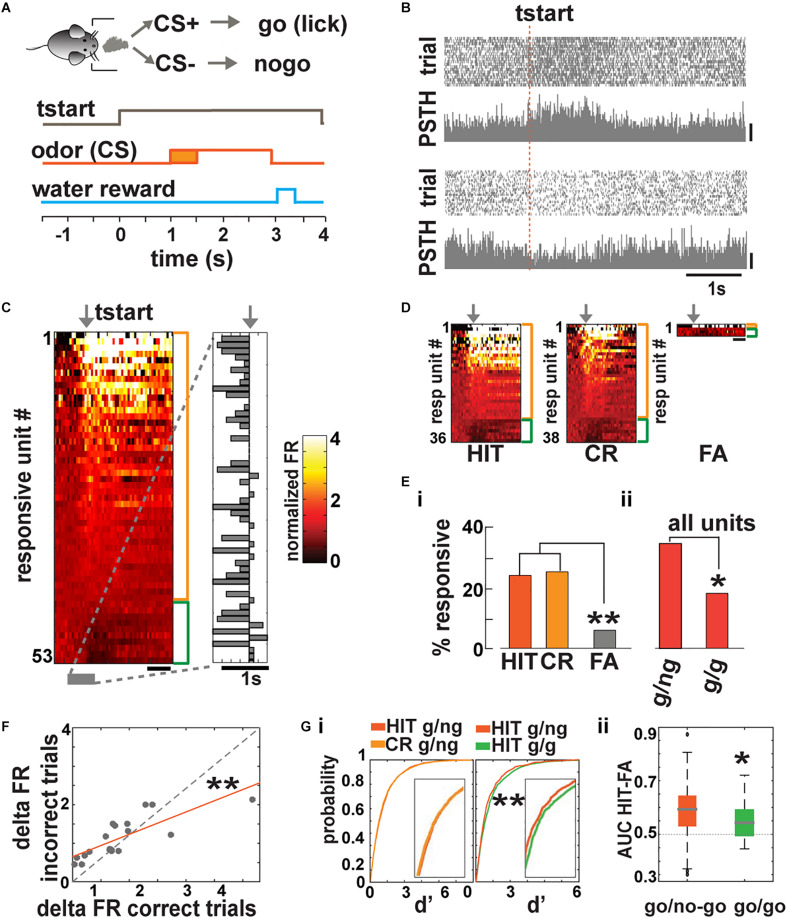
Basal forebrain (BF) neuronal activity is recruited during trial initiation in a go/no–go task. (A) The odor is delivered 1.5 ± 0.5 s after the mouse starts the trial. In response to CS+, the animal must lick at least once in four 0.5-s segments to receive a water reward. (B) Spike scatterplot for two BF single units in the go/no–go task for a mouse performing >80% correct responses. FR increased for one unit (top; scale bar, 50 Hz) and decreased for the other (bottom; scale bar, 20 Hz) during trial initialization (tstart). (C) Heat map depicting the normalized mean firing rate of all responsive units aligned by tstart (arrow; side bars, orange: FR increase, –43/153– total; green: FR decrease, –10/153–; scale bar, 1 s). A unit is classified as responsive if there is a statistical difference between the FR after the animal entered the port compared to the FR of that unit before the animal entered the port (p < pFDR; pFDR, the FDR critical significance level per animal, ranged from 0.006 to 0.03; n = 153 units, 141 single units, and 12 multiunits from 8 mice and 10 sessions). Right, bar graph showing the time point where the FR changed ±2 standard deviations (SD) from the mean. (D) Heat maps depicting the normalized FR of responsive units sorted by correct responses (hit and correct rejection, CR) and incorrect trials (false alarms, FA; scale bar, 1 s). We did not find miss responses. (E) Percent of responsive cells for FR aligned to tstart sorted by behavioral outcome and task. A larger number of neurons (i) respond to correct responses (HIT and CR) when compared to incorrect responses (FA, go/no–go HIT and CR different from FA, chi-squared test pFDR = 0.05, **pHIT vs FA = 0.001, **pCR vs FA = 0.0008) and more units (ii) were recruited during the go/no–go task compared to the go/go (chi-squared test pFDR = 0.05, *ptotal = 0.03; g/ng, go/no–go; g/g, go/go). (F) The change in FR during tstart is significantly different between correct and incorrect trials (ANCOVA, F = 16.6, Tukey’s post hoc, **p = 0.0004). (G) Left, cumulative probability function of d’ for all the recorded units. The curves were not different between correct responses (HIT and CR) in the go/no–go task but were different between HIT in the go/no–go and go/go (**KS test p = 3.6 × 10−8). Right, whisker plot for the area under de curve (AUC) of each unit in ROC space. Units acted as better classifiers in the go/no–go test compared to the go/go t-test, *p = 0.03.